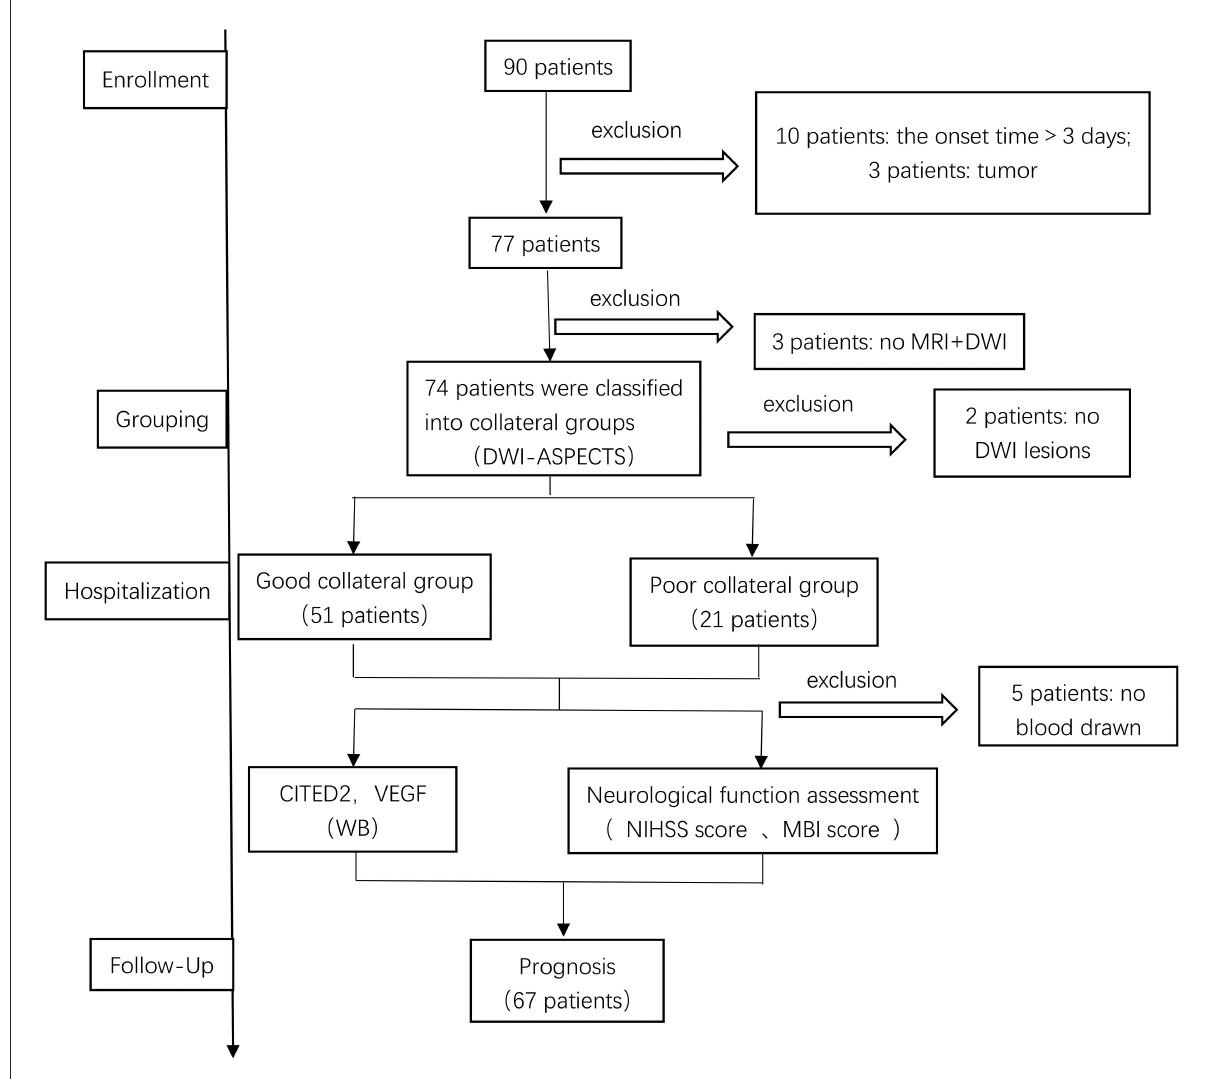
FIGURE2 Patient selection. DWI-ASPECTS, diffusion weight image–Alberta Stroke Program Early CT Score; CITED2, CBP/P300-interacting transactivator with Glu/Asp-rich C-terminal domain 2; VEGF, vascular endothelial growth factor; WB, Western blot.